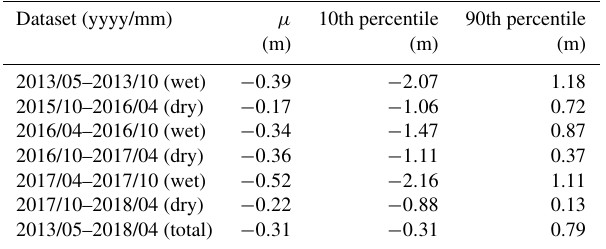
Table 2. Extreme values below and above which the data are re- moved from the original dataset, as well as the mean of the whole dataset ( µ